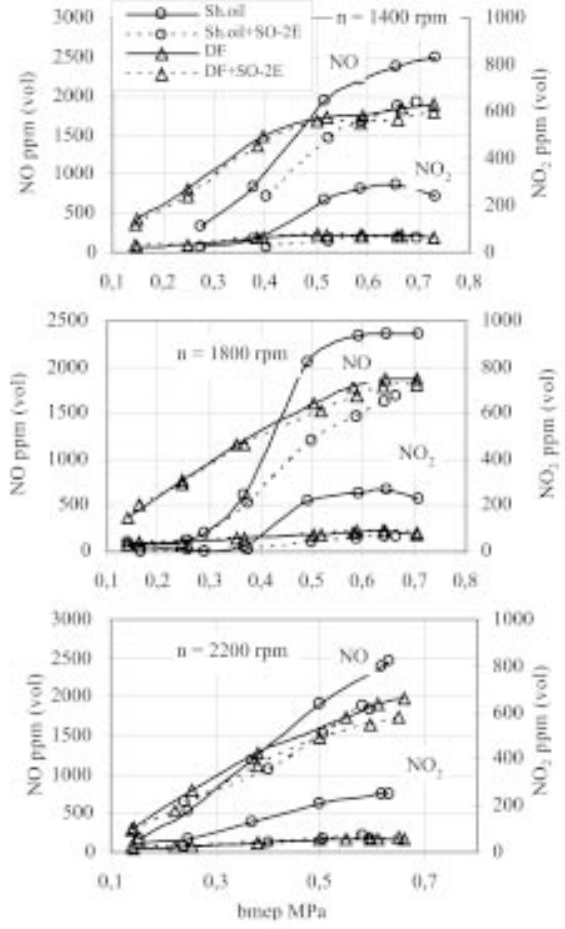
Fig 2 . Dependencies of nitric monoxide NO and nitrogen dioxide NO emissions on the engine load (bmep) at various 2 revolution